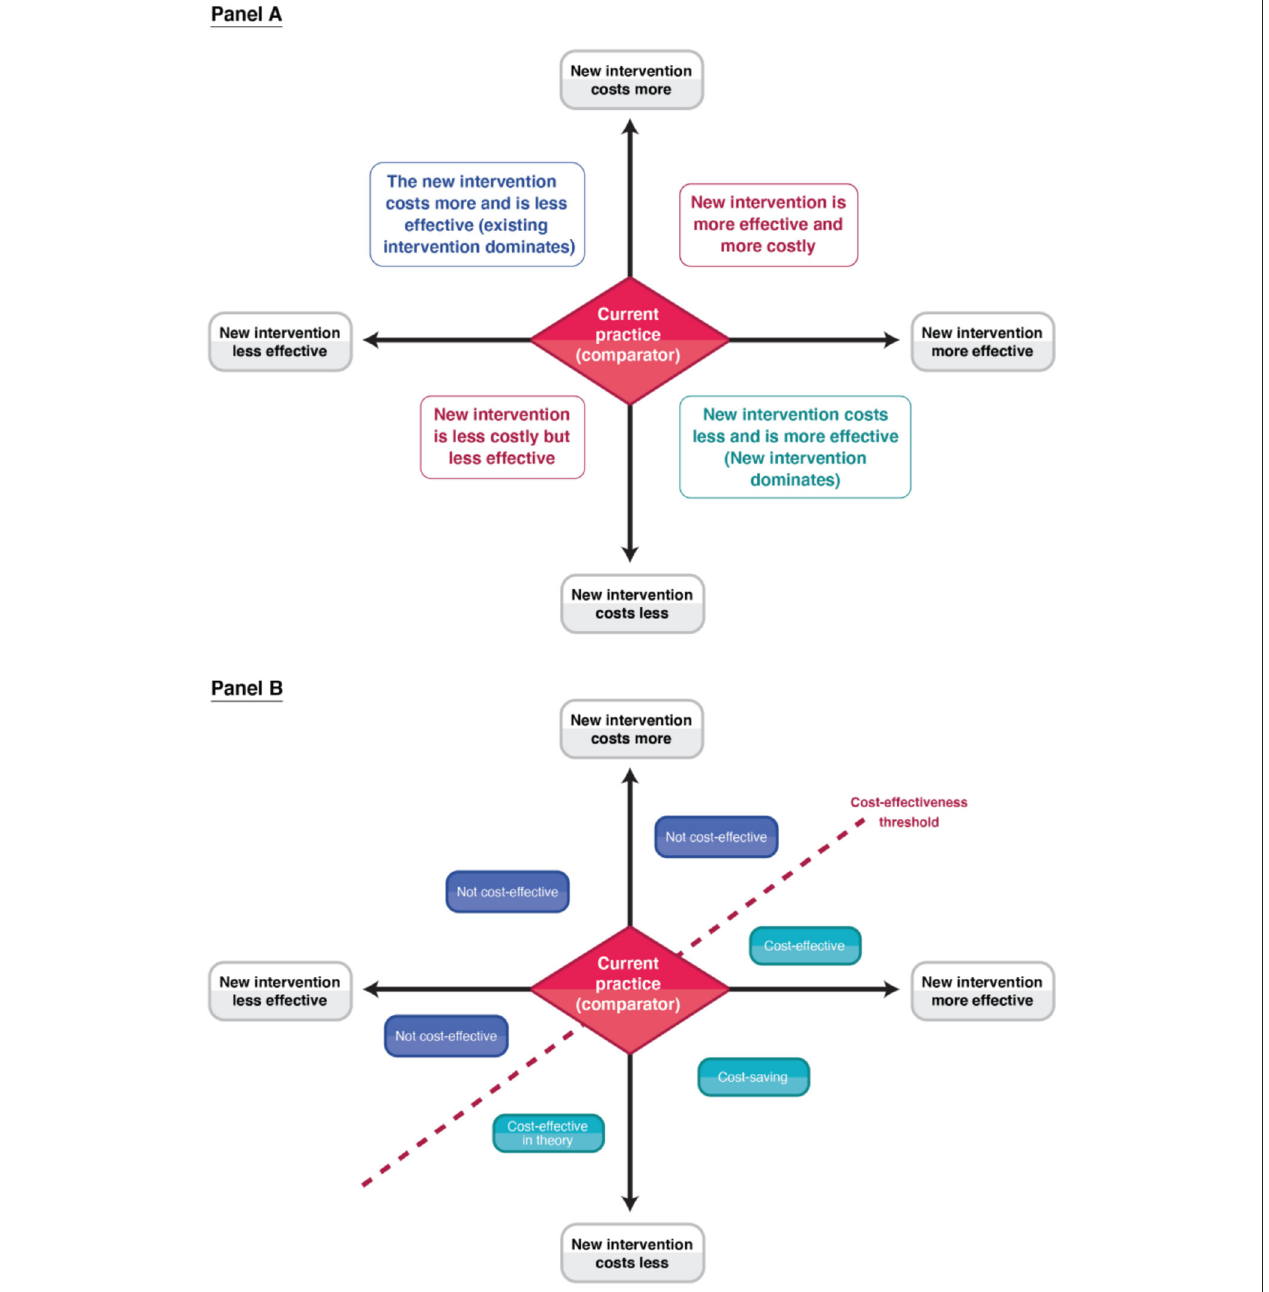
FIGURE 3 | A schematic of the cost-effectiveness plane. Panel A indicates the four different quadrants. Panel B illustrates the different decision rules in relation to a cost-effectiveness threshold within the different